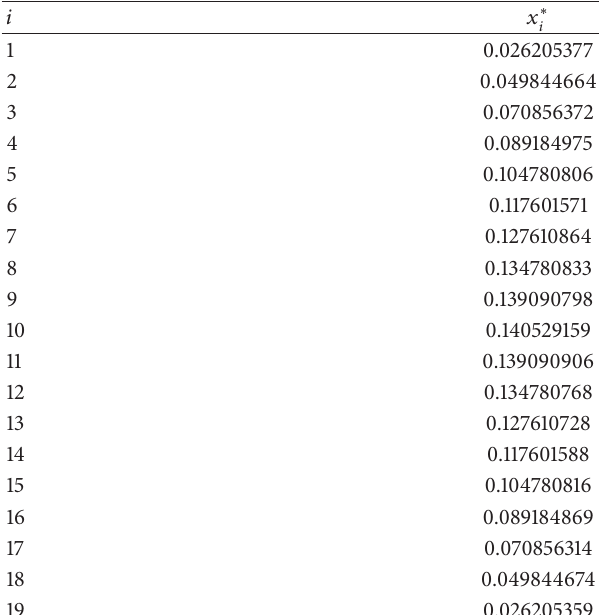
Table 5: Approximated